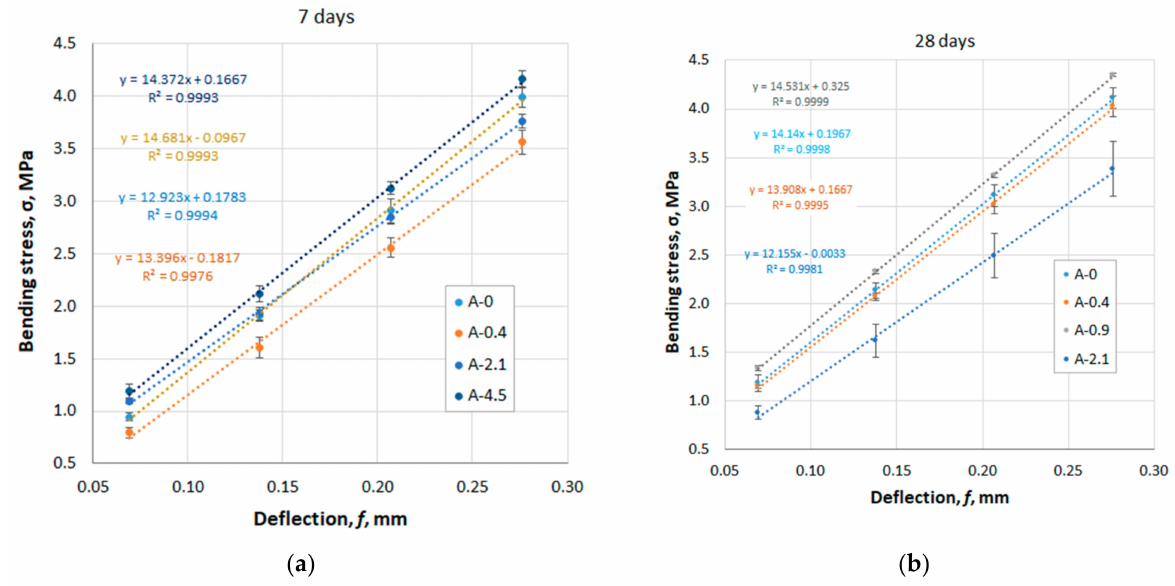
Figure 6. The results of measuring the deflection of specimen’s series A depending on the applied stress: ( a ) 7 days; ( b ) 28